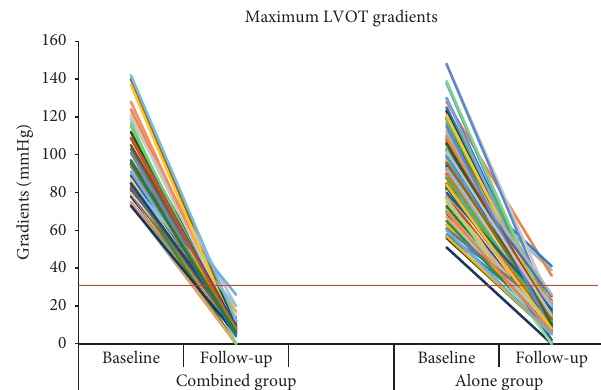
Figure 3: Maximum LVOT gradients before myectomy and at the latest follow-up. The red line represents a gradient level of 30mmHg. LVOT, left ventricular outflow